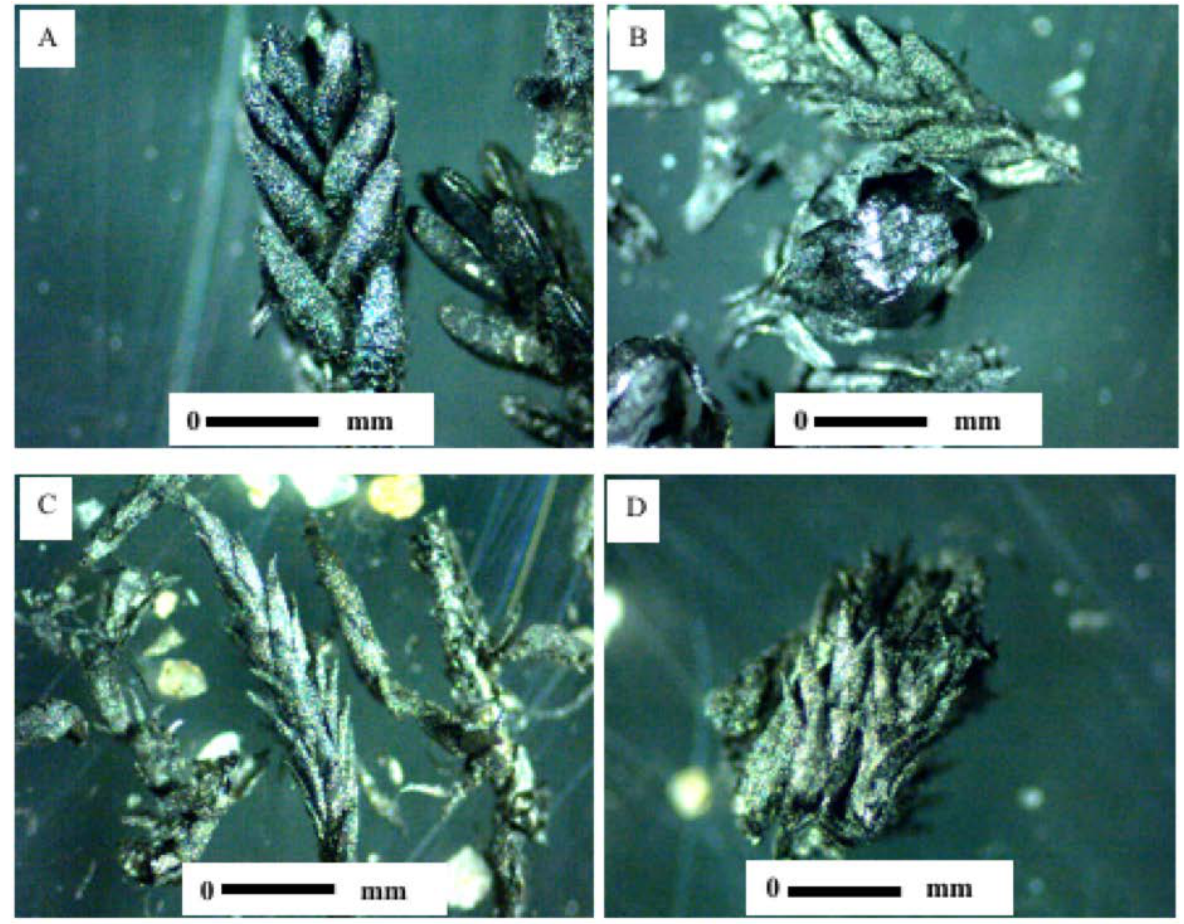
Figure 1. Charcoal produced by charring All Saints Bog peat. A and B: charred Calluna vulgaris ; C and D: charred Sphagnum moss